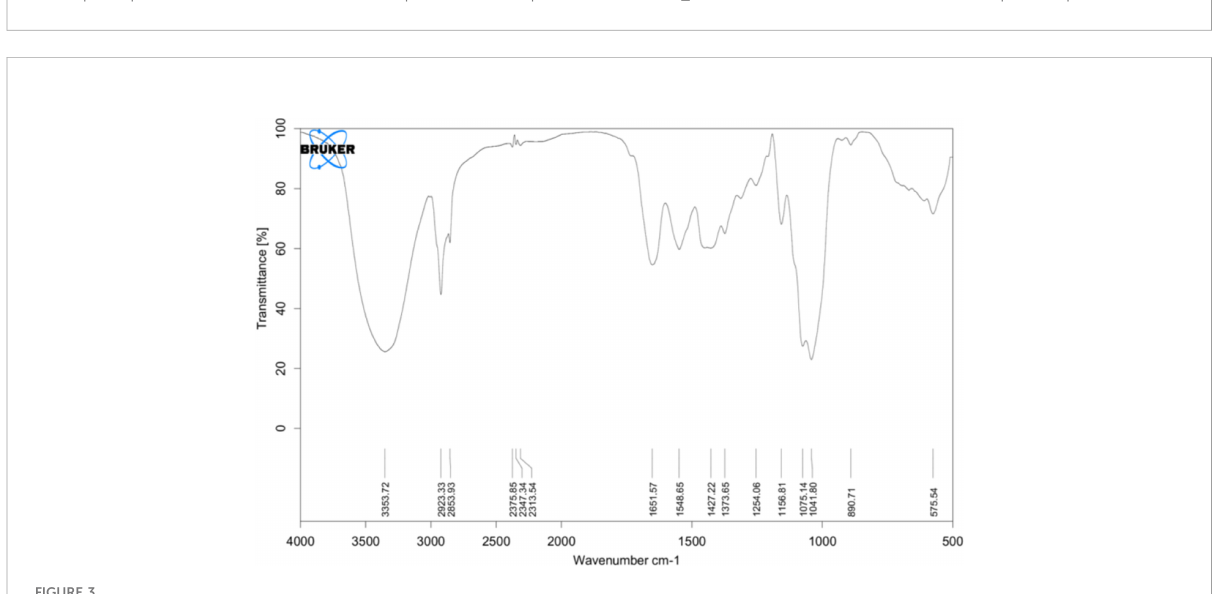
FIGURE 3 FTIR analysis: transmittance spectra of yeast b -glucan con fi rming the nature of polysaccharides and showing the presence of 1,3 as a major linkage in b -glucan sample. FTIR, Fourier transform